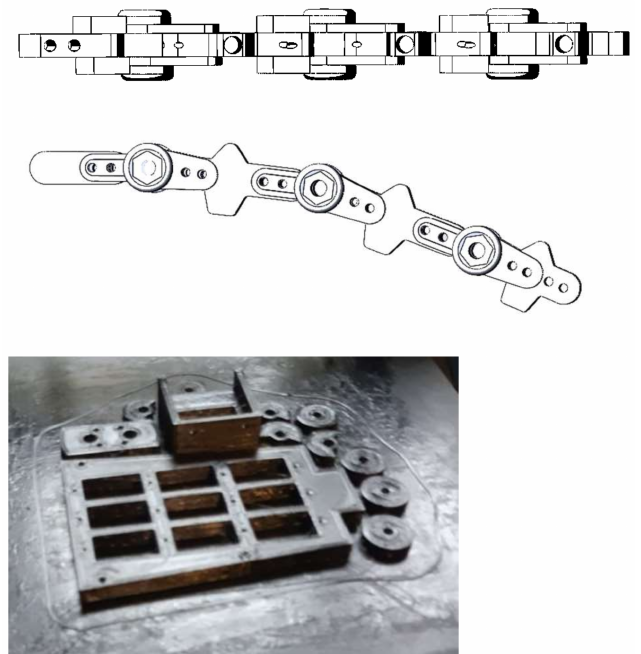
Figure 2. Designed and assembled finger construction made using three-dimensional printing technology; the process of manufacturing components of the